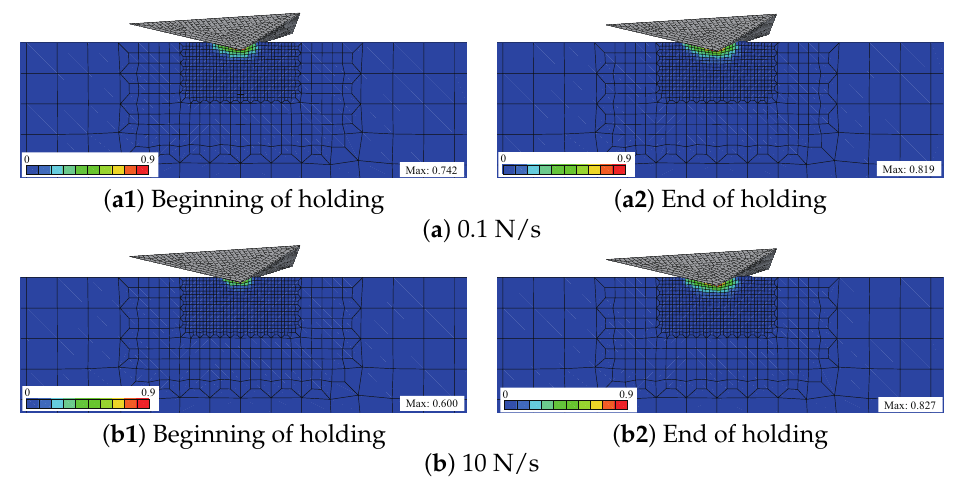
Figure 7. Equivalent plastic strain distribution at the beginning and end of the holding processes in the computational simulations using the determined material constants for α ∈ ( 0,1 ) .